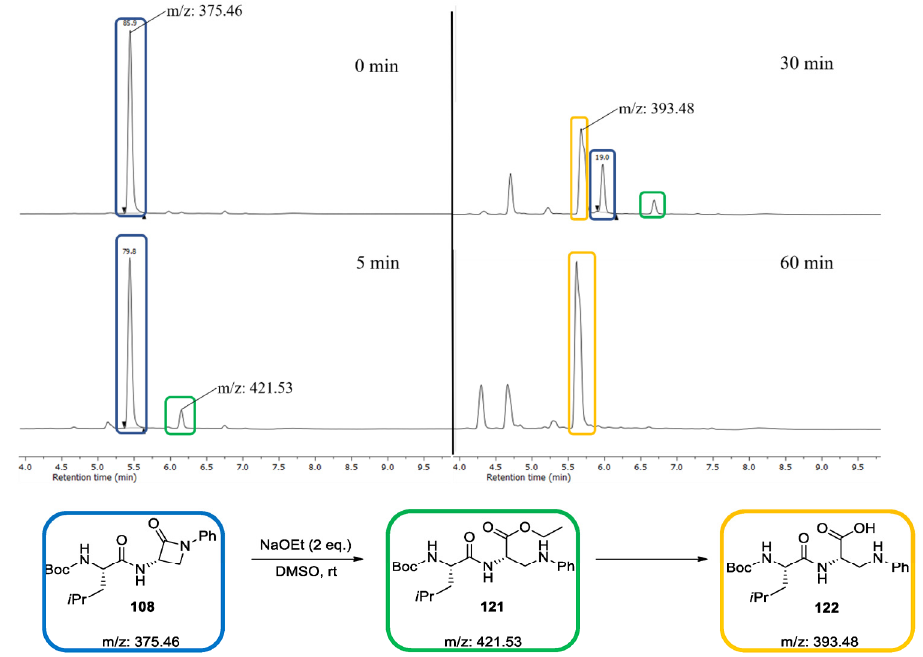
Figure 3. LC-MS spectra of the β -lactam 108 before (0 min) the addition and after 5, 30 and 60 min reaction time with sodium ethoxide.